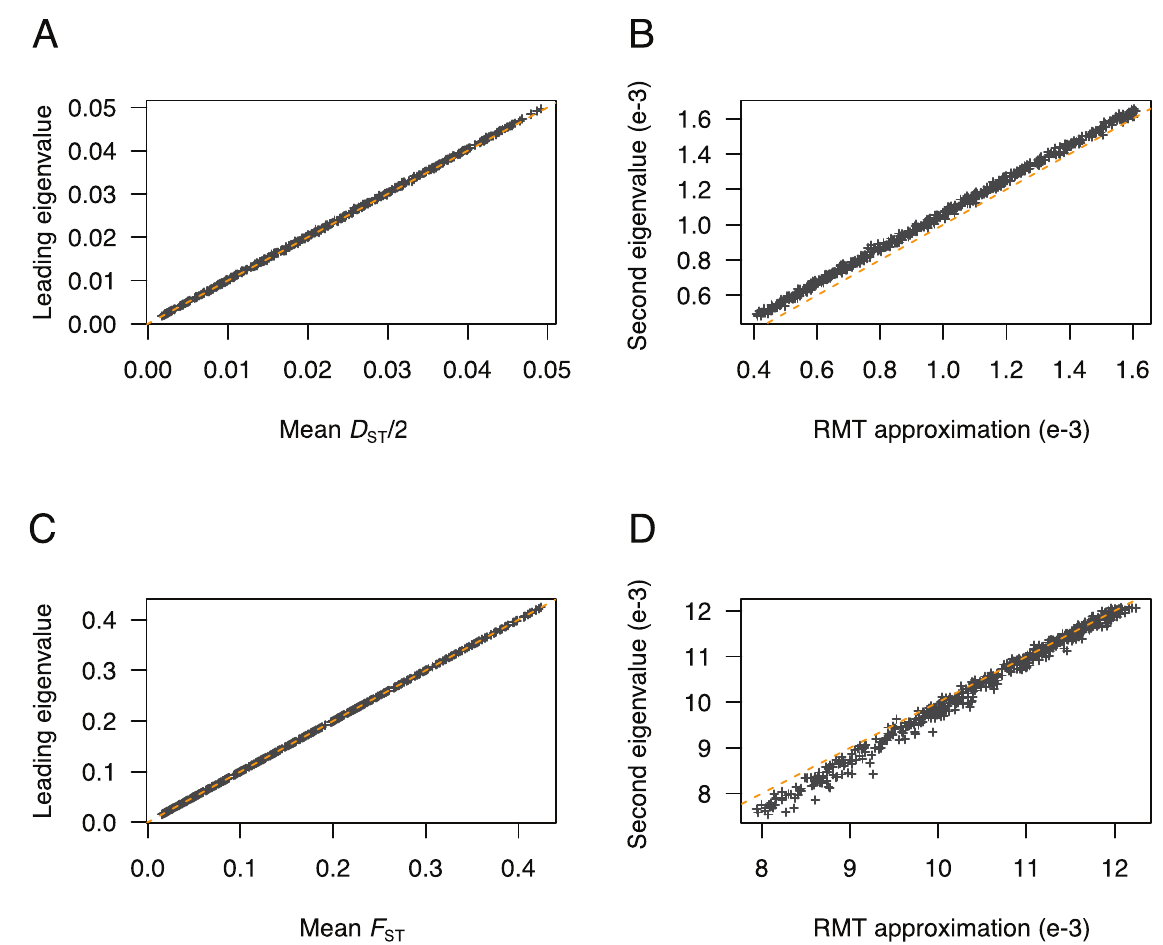
Fig 3. Comparison of D ST and F ST estimates with the leading PCA eigenvalues in two-population models. ( A ) Leading eigenvalues of centered PCA as a function of the mean of D ST /2 across loci. ( B ) Second eigenvalue of centered PCA as a function of its approximation from RMT. ( C ) Leading eigenvalues of scaled PCA as a function of the mean of F ST across loci. ( D ) Second eigenvalue of scaled PCA as a function of its approximation from RMT, which is given by ð 1 (cid:0) r 2 matrix). The dashed lines correspond to the diagonal y = x . Simulations of F -models were performed for n = 100 individuals (inbreeding coefficients between 1% and 75%, first population sample proportion between 10% and 50%, ancestral frequency was drawn from a beta(1,4)